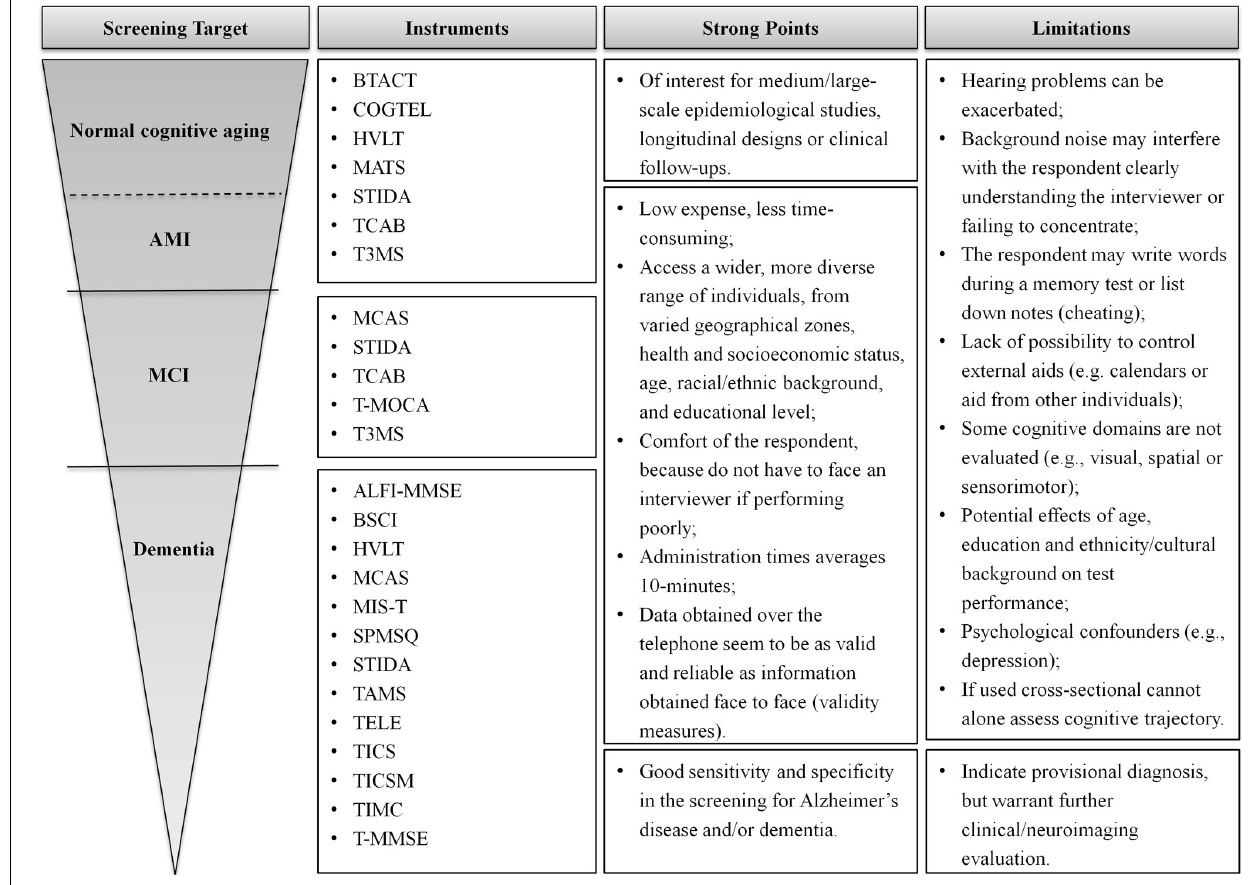
FIGURE 2 | Summary of the instruments for different screening goals. Key advantages and limitations of each set of instruments are identified. The choice of an appropriate screening measure depends on the question being asked and the sample